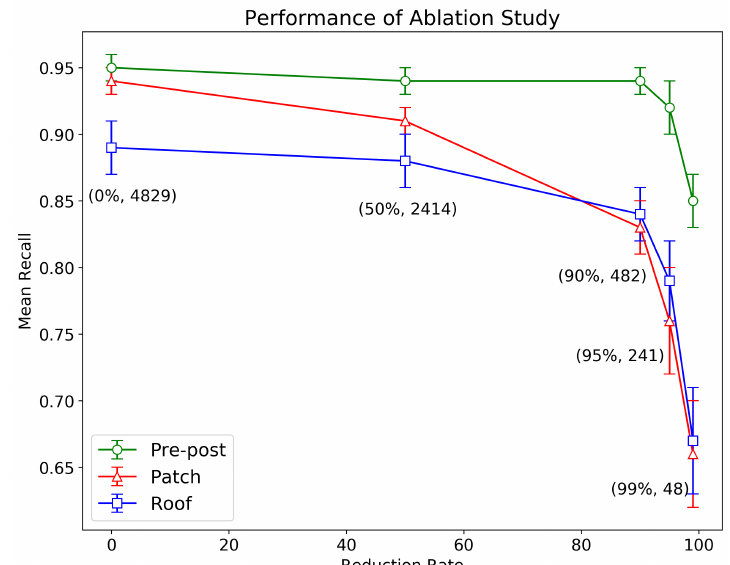
Figure 12. Performance of the ablation study.